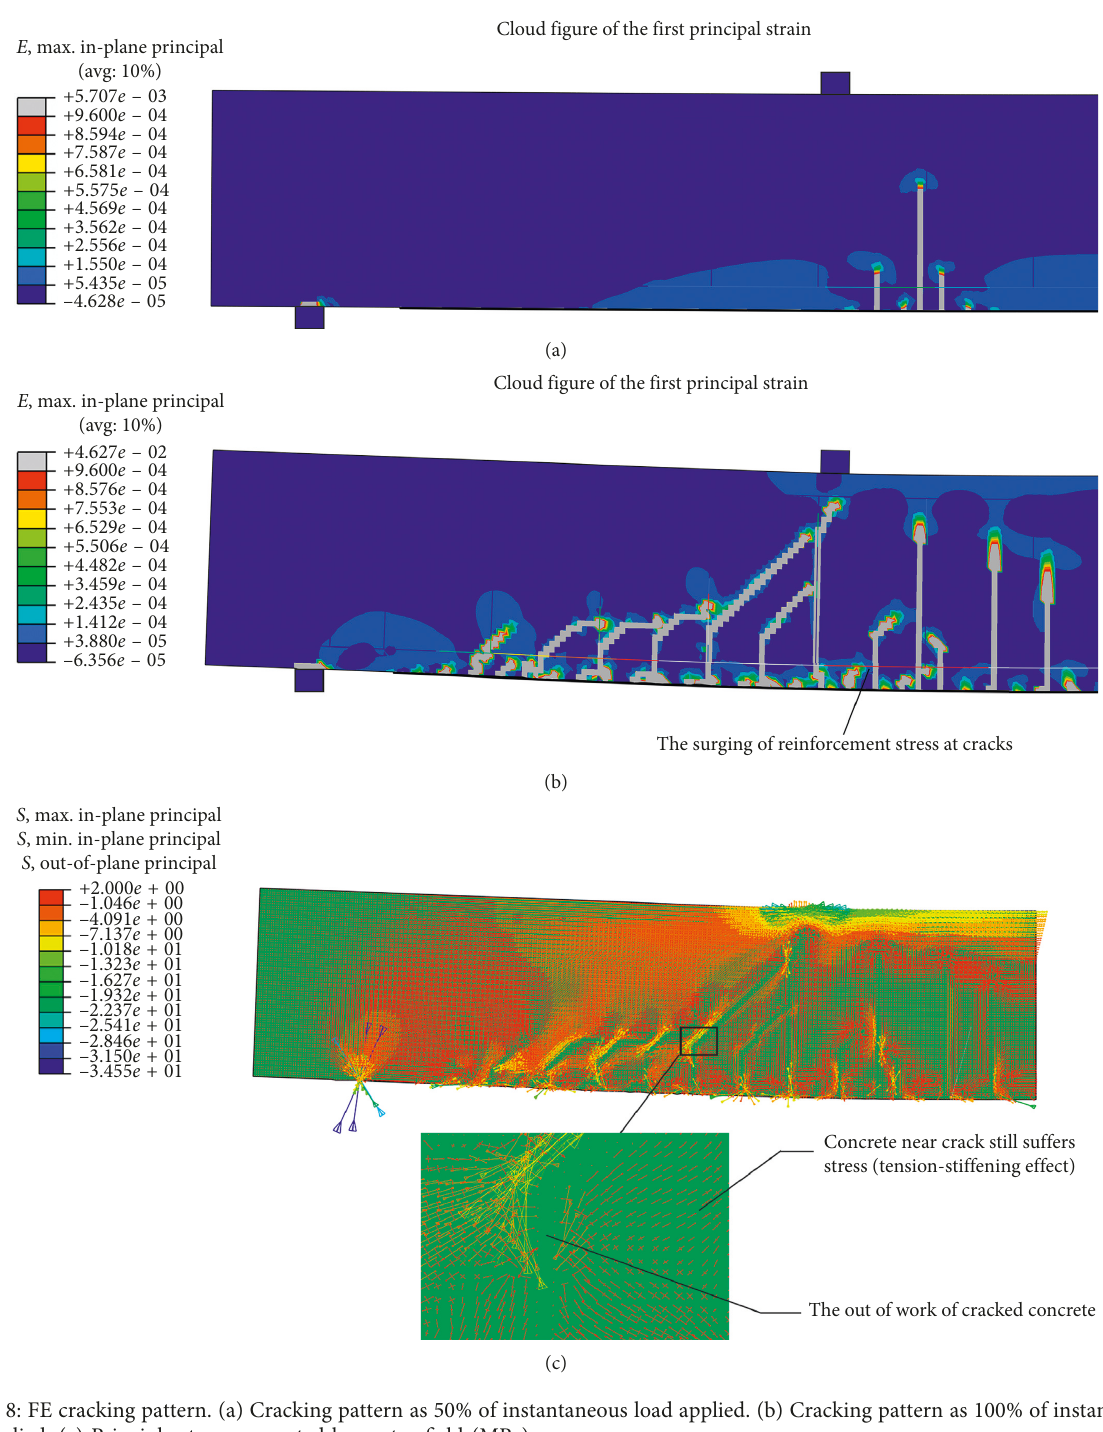
Figure 8: FE cracking pattern. (a) Cracking pattern as 50% of instantaneous load applied. (b) Cracking pattern as 100% of instantaneous load applied. (c) Principle stress presented by vector field